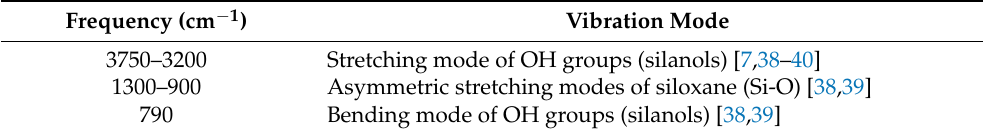
Table 3. IR frequencies and assignments of